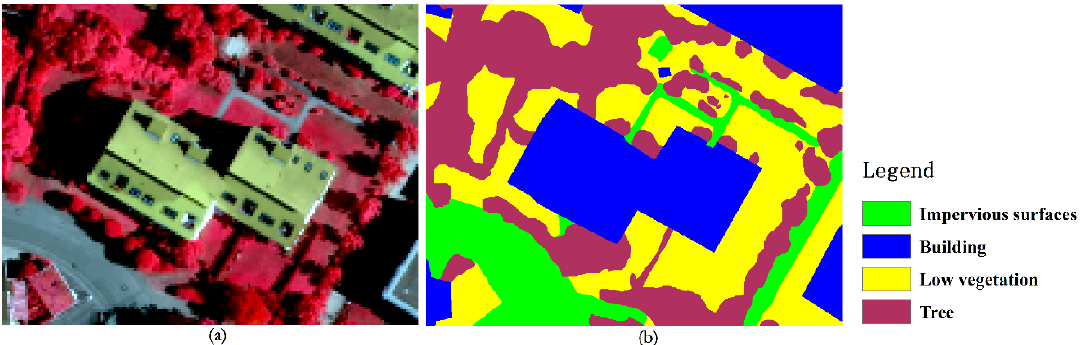
Figure 5. Vaihingen image: ( a ) false color original Vaihingen image and ( b ) ground truth reference image.